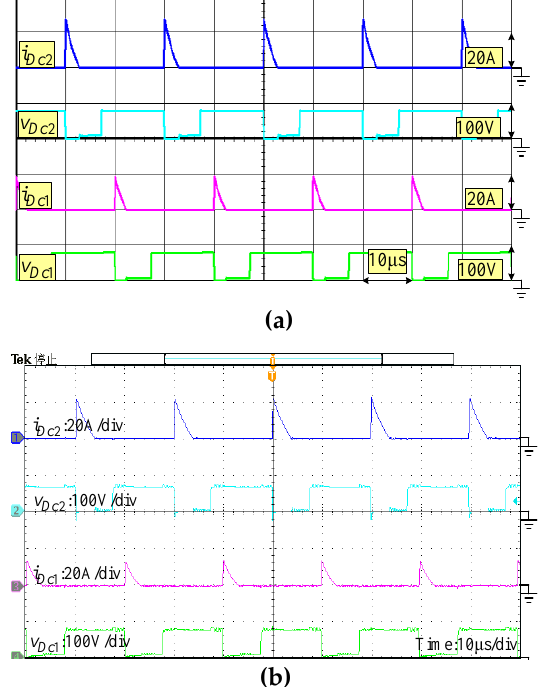
i , , i and v . ( a ) Simulated results. ( b ) Experimental 1 Dc 2 Dc 2 Dc results.